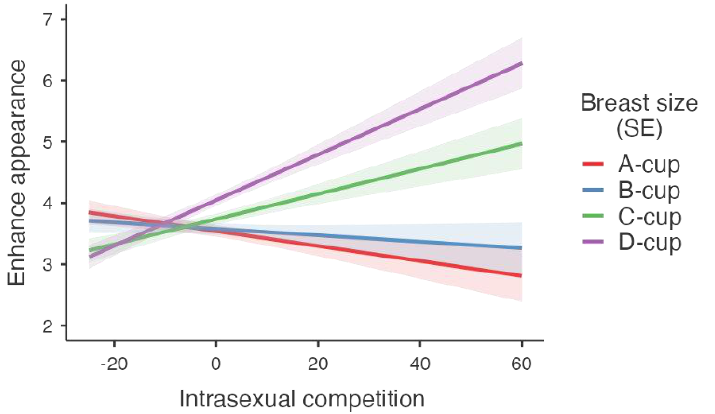
Figure 4. Intrasexual competition moderating the relationship between breast sizes and enhancing appearance.